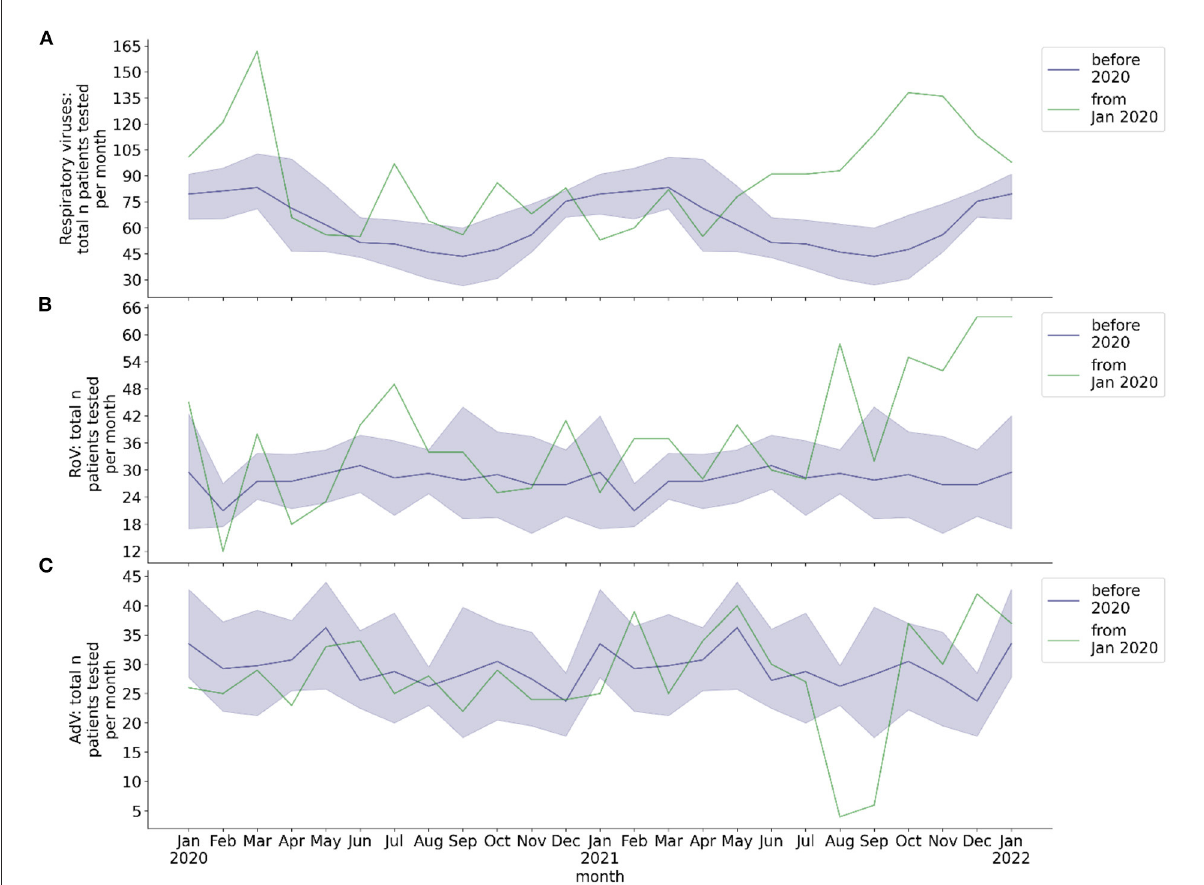
FIGURE2 Total monthly number of hospitalized patients at BCH tested for respiratory viruses and for RoV and AdV, respectively. Blue line: mean 2016-2019, blue shade: 95% confidence interval 2016-2019, green line: absolute number per month from 2020, calendar months 2016-2019 are shown as a historical reference and correspond to calendar months, not to year on x-axis. (A) Total number of patients per month with molecular biology testing of respiratory samples for respiratory viruses; (B) total number of patients per month with EIA or molecular biology testing of stool sample for RoV; (C) total number of patients per month with molecular biology testing of stool sample for